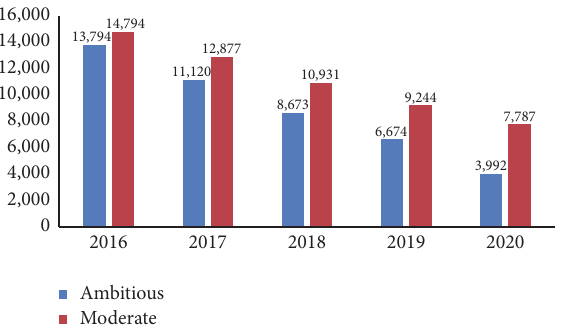
Figure 2: Number of pneumonia and diarrhoea deaths in moderate and ambitious scale-up scenarios